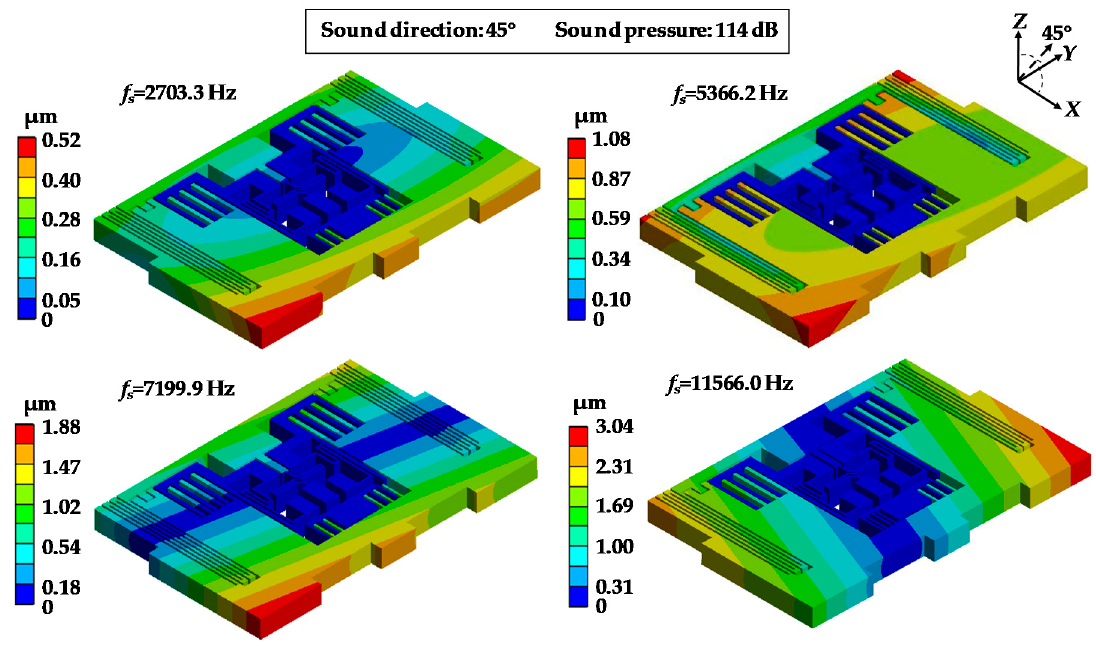
Figure 9. Deformation distributions of MPU6050-Y under acoustic injection of different sound frequencies.